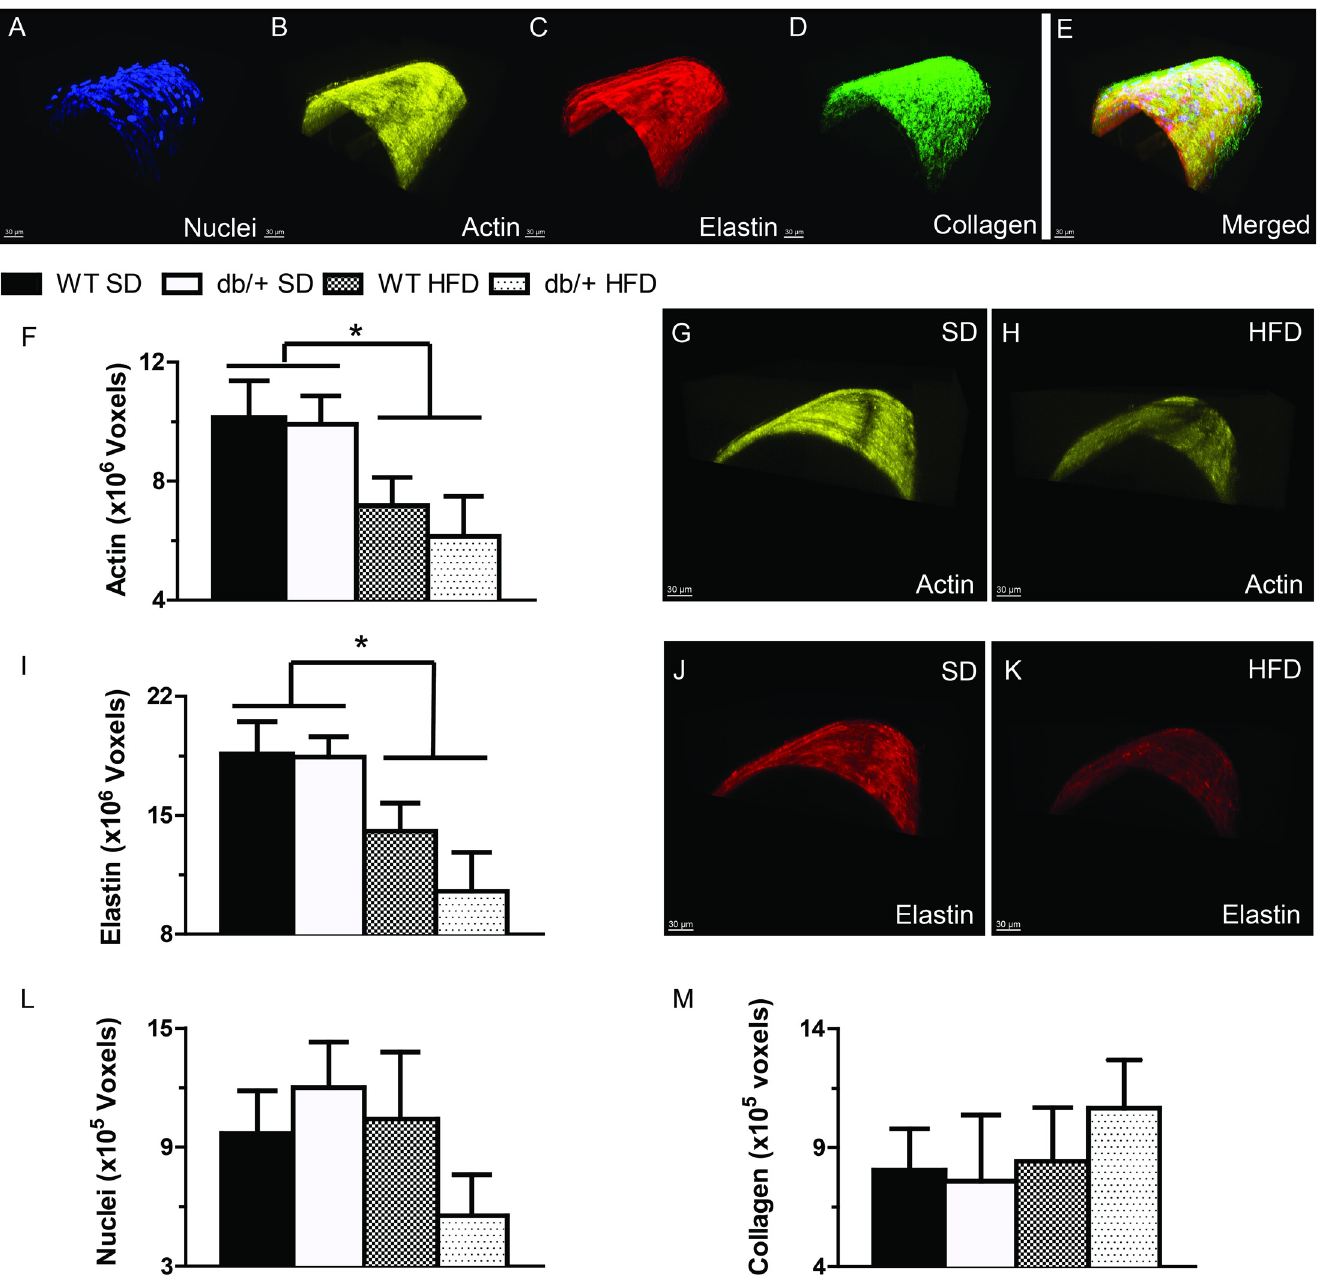
Fig 9. Effect of maternal environment and offspring diet on the morphological characteristics of mesenteric resistance arteries from adult (31 week-old) wild type (WT) male offspring of WT-control or Lepr db/+ (db/+) dams. (A-E) Representative confocal images of mesenteric resistance arteries showing (A) nuclei; (B) F-actin; (C) elastin; (D) collagen; and (E) merged image. (F-H) Group data and representative images showing that feeding a high-fat diet was associated with a significant reduction in arterial F-actin content. (I-K) Group data and representative images showing that feeding a high-fat diet was associated with a significant reduction in arterial elastin content. (L) Vascular smooth muscle cell number, represented by nuclei contained within the medial layer of mesenteric arteries. (M) The amount of collagen contained in the wall of mesenteric arteries. Data are means ± SEM of n = 5 – 7 number of animals (vessels) per treatment group combination. * P < 0.05. SD, standard diet; HFD, high fat